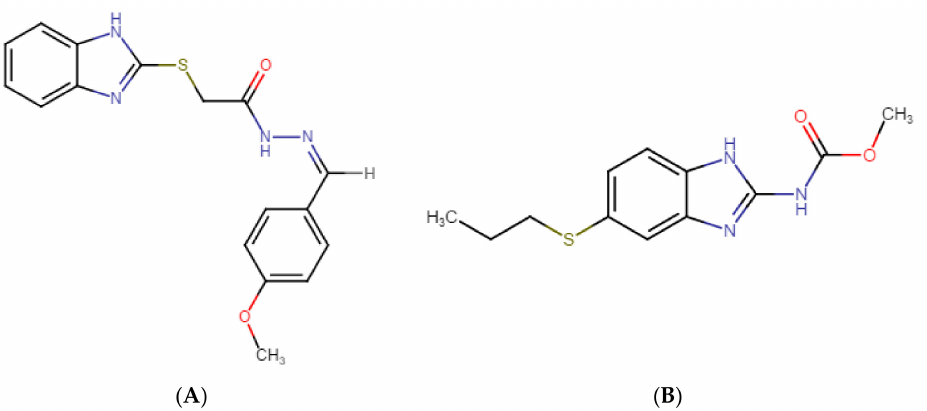
Figure1. Chemicalstructuresof( A )GMC1(2-(1H-benzimidazol-2-ylsulfanyl)- N